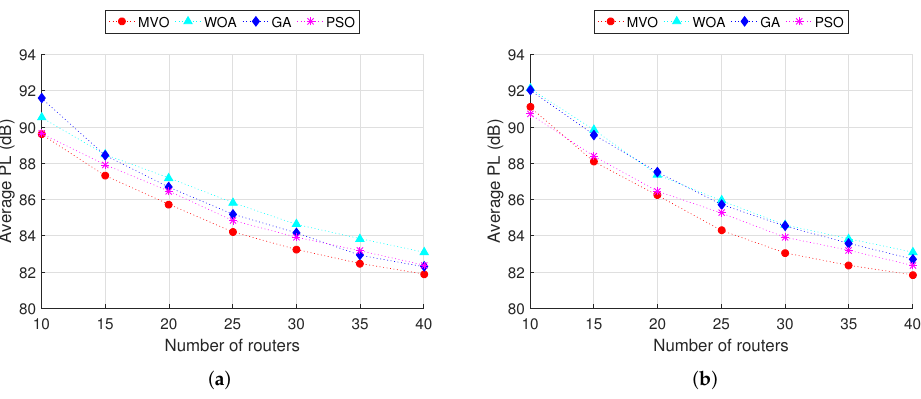
Figure 6. Performance comparison of the path loss versus the number of routers. ( a ) INS-1. ( b ) INS-2.